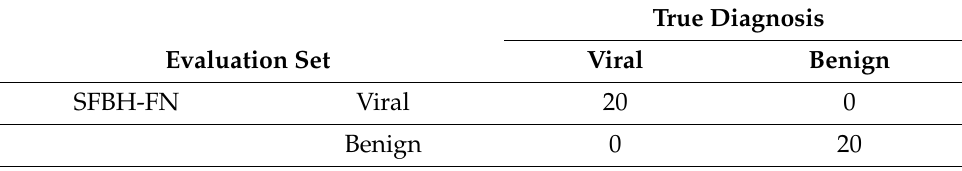
Table 13. OC-SVM model: SF&BH-FR. True Diagnosis Evaluation Set Viral Benign SFBH-FN Viral 64 36 Benign 14 6